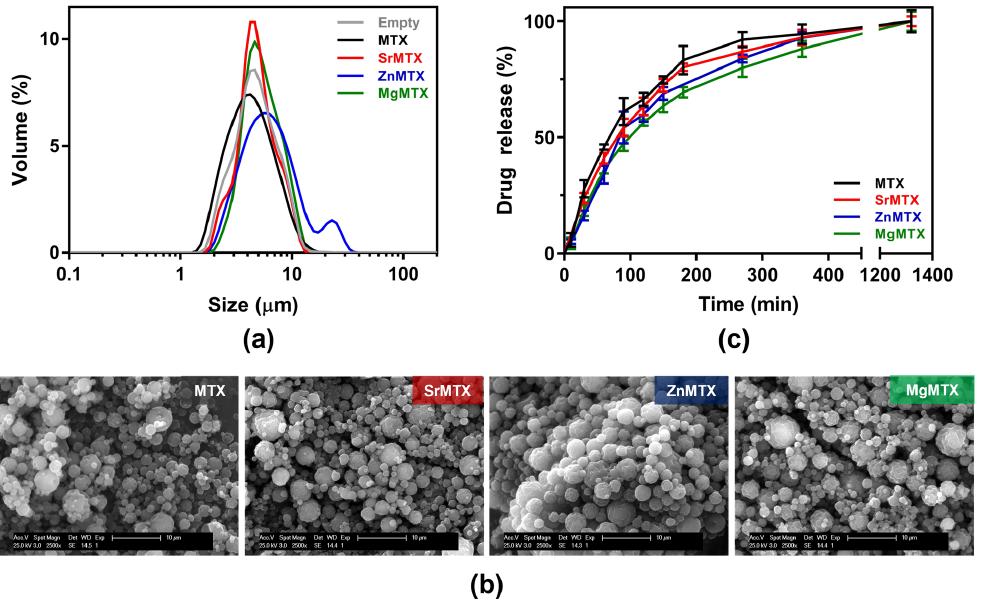
Figure 8. Characterization of chitosan microparticles loaded with MTX and its derivatives: ( a ) Size dispersion analysis, ( b ) Scanning electron microscopy images, and ( c ) Cumulative drug-release profiles.